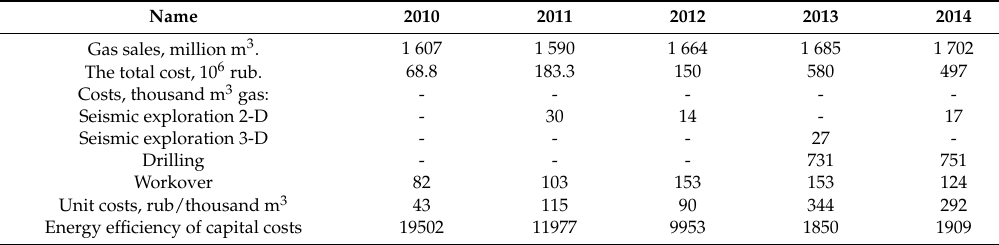
Table 6. Unit capital cost and energy efficiency capital costs of JSC “YATEC.”